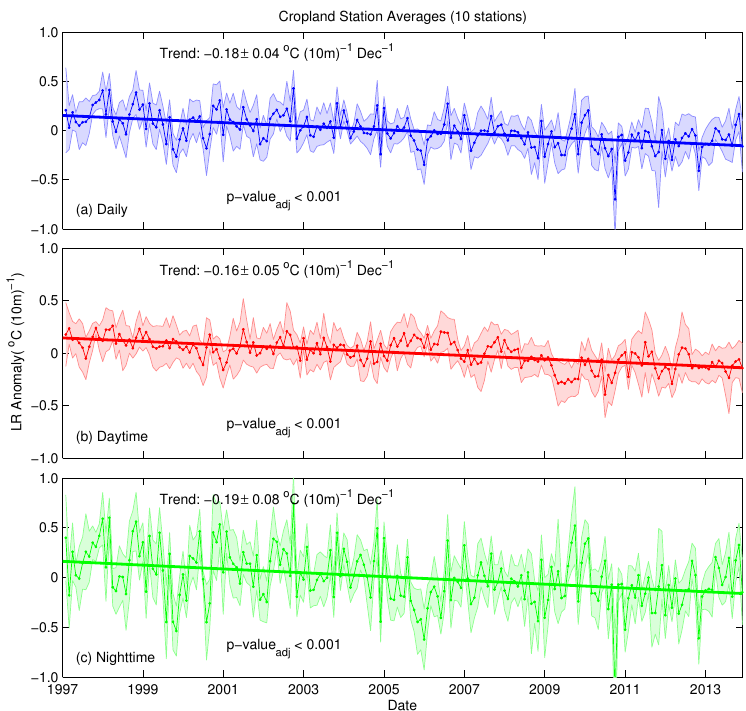
Figure 8. The same as Fig. 7 but only for 10 cropland station